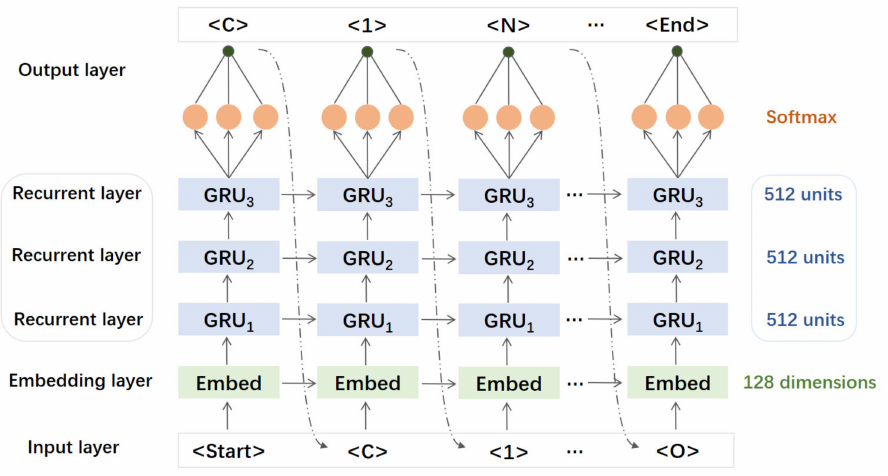
Figure 3. The architecture of the GRU-based recurrent neural